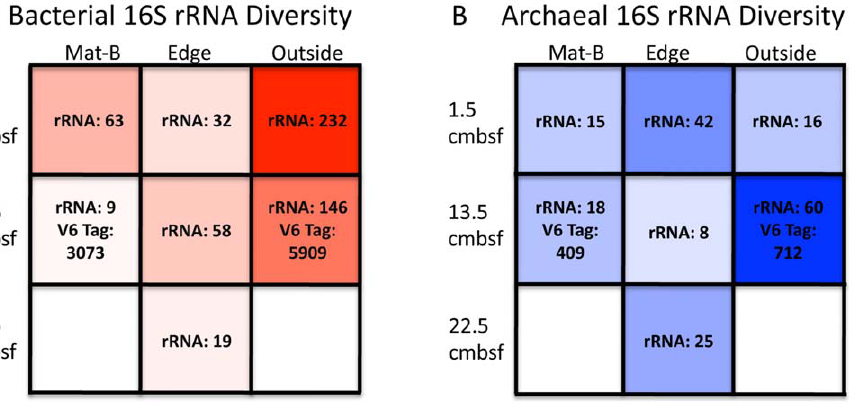
Figure 5. Diversity estimates of bacteria and archaea. Chao1 diversity estimates for rRNA clone libraries (rRNA) and where available for tag sequencing (V6 Tag) are listed for (A) bacteria and (B) archaea at different depths in the mat, at its edge, and just outside the mat. Transparency of each block corresponds to diversity relative to the highest diversity sample. Clone library sample sizes are the same as those in Figs. 3a and 4a.